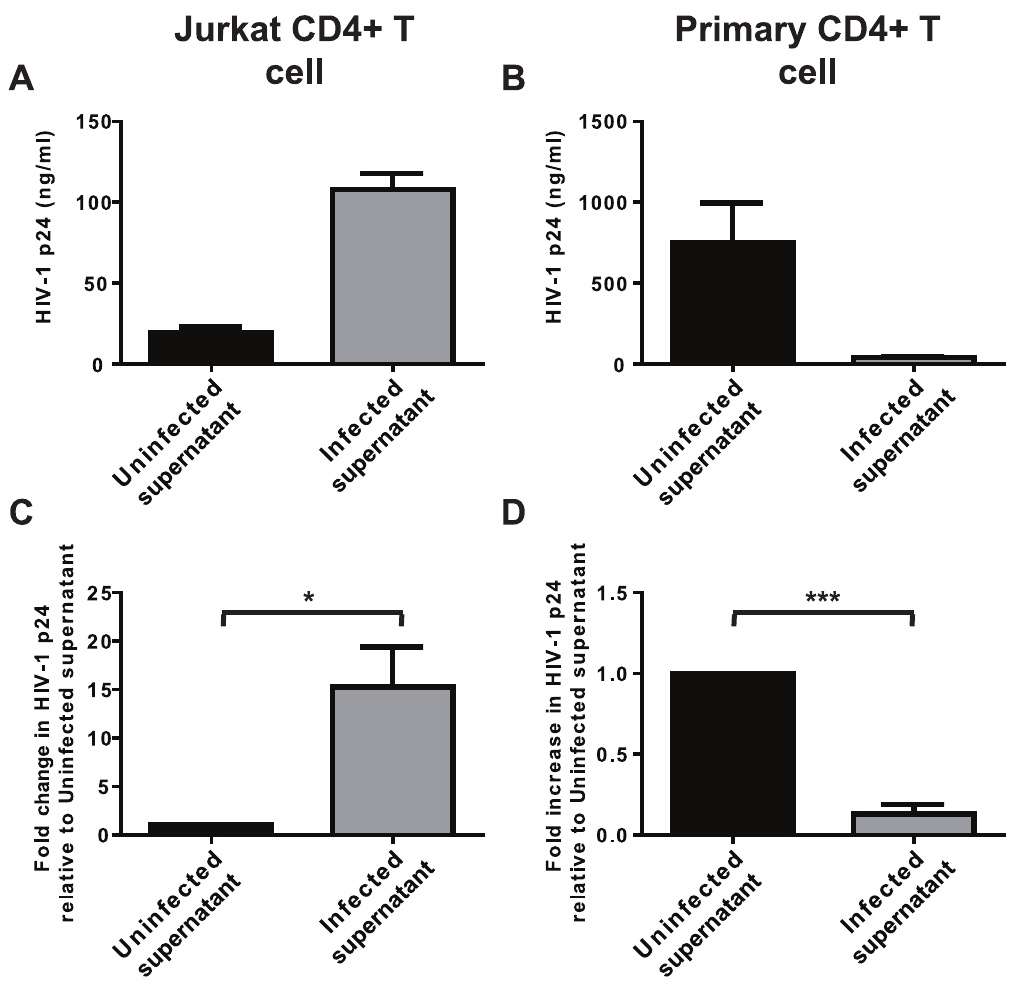
Figure 2. Supernatants from gonococcal-infected PBMCs have opposite effects on immortalized and primary HIV-infected CD4 + T cells. HIV-1-infected Jurkat CD4 + T cells (A and C) or T cell receptor crosslinking antibody-activated primary CD4 + T cells (B and D) were exposed to culture supernatants from gonococci-infected (but HIV-uninfected) PBMCs that had been infected with N. gonorrhoeae at a MOI of 10 (Infected supernatant) or left uninfected (Uninfected supernatant) for 5 or 7 days, respectively. Subsequently, the level of HIV-1 replication was quantified by ELISA for p24 antigen. (A) and (B) represent the mean 6 s.d. of the actual p24 antigen levels of triplicate wells from one representative experiment. Due to the difficulty in replicating exact HIV-1 infection levels experiment to experiment, (C) and (D) represent the mean 6 s.e.m. of a minimum of 3 separate experiments with the amount of HIV-1 replication expressed as the percentage of p24 antigen found in uninfected supernatant exposed samples to allow statistical measurements to be performed. Significant differences are represented by comparison with the following legend: *p # 0.05, ***p # 0.001.